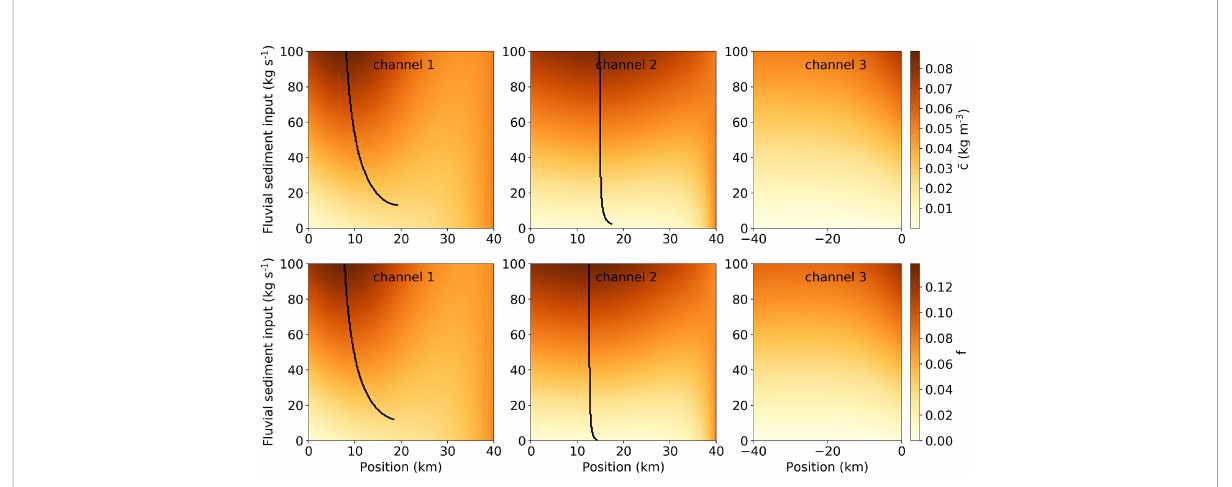
FIGURE 8 Sensitivity of along-channel distributions of depth-averaged subtidal concentration ( fi rst row) and availability (second row) to fl uvial sediment input. Black curves indicate the location of local maxima.